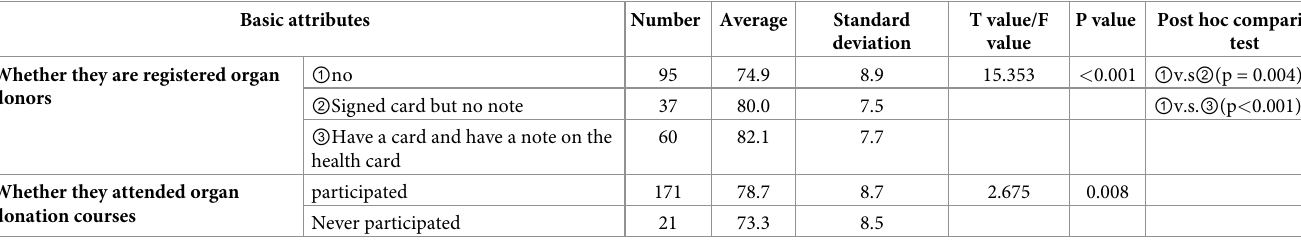
Table 1. Factors related to participants’ basic attributes and attitudes toward organ